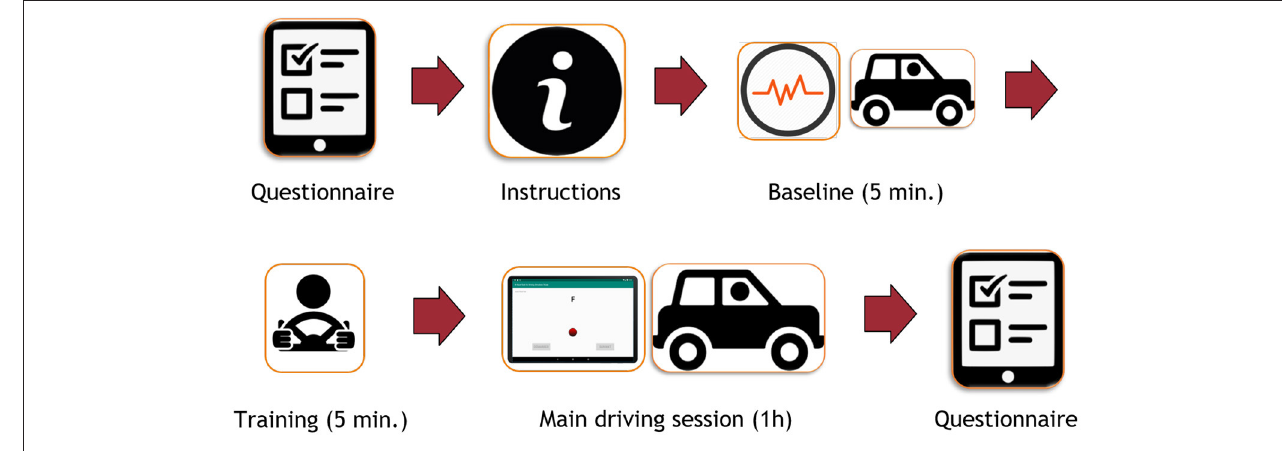
FIGURE 3 | Global experimental procedure of the study.